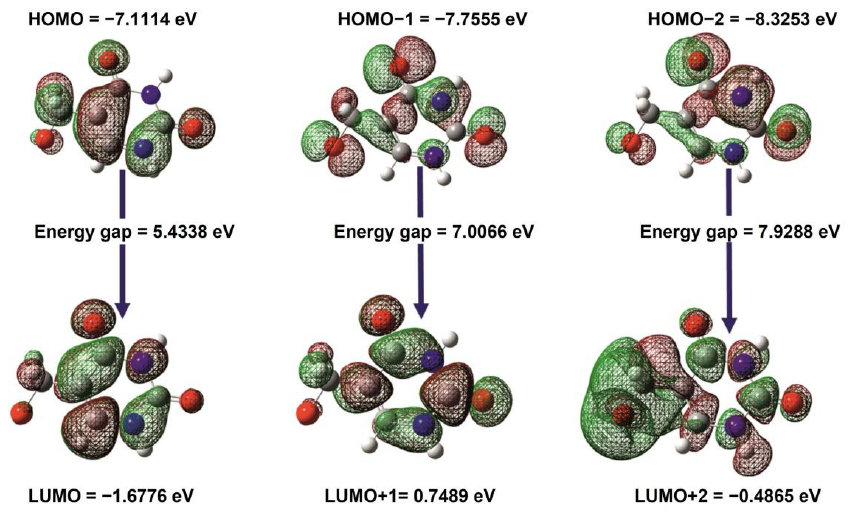
Figure 7. UV–Vis spectra of 5-HMU: Theoretical in the gas phase, DMSO, and Methanol and Experimental in different solvents and experimental in DMSO.